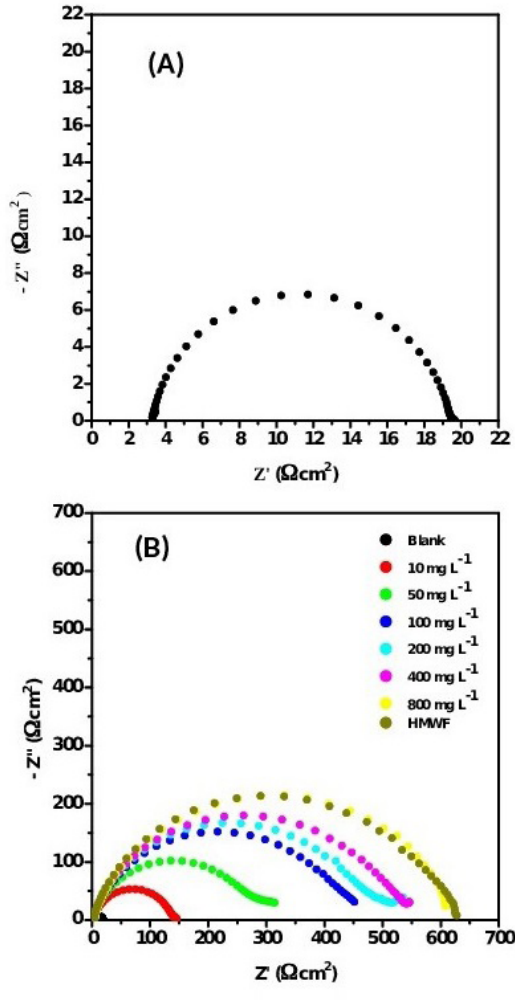
Figure 3. Nyquist plots obtained for mild steel in 1 mol L −1 HCl (A) in the absence of inhibitor and (B) in the presence of different concentrations ACSE and at 400 mg L −1 of its HMWF.